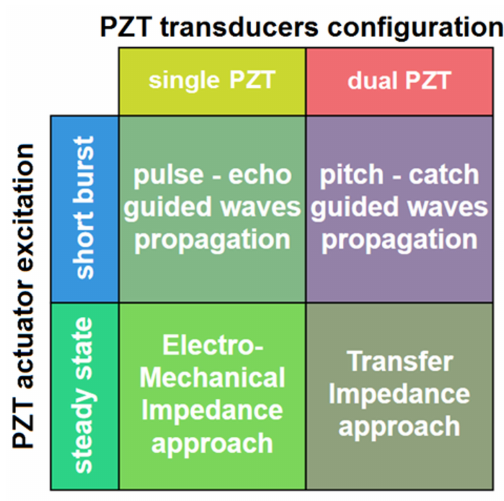
Figure 1. Methods of PZT application for Structural Health